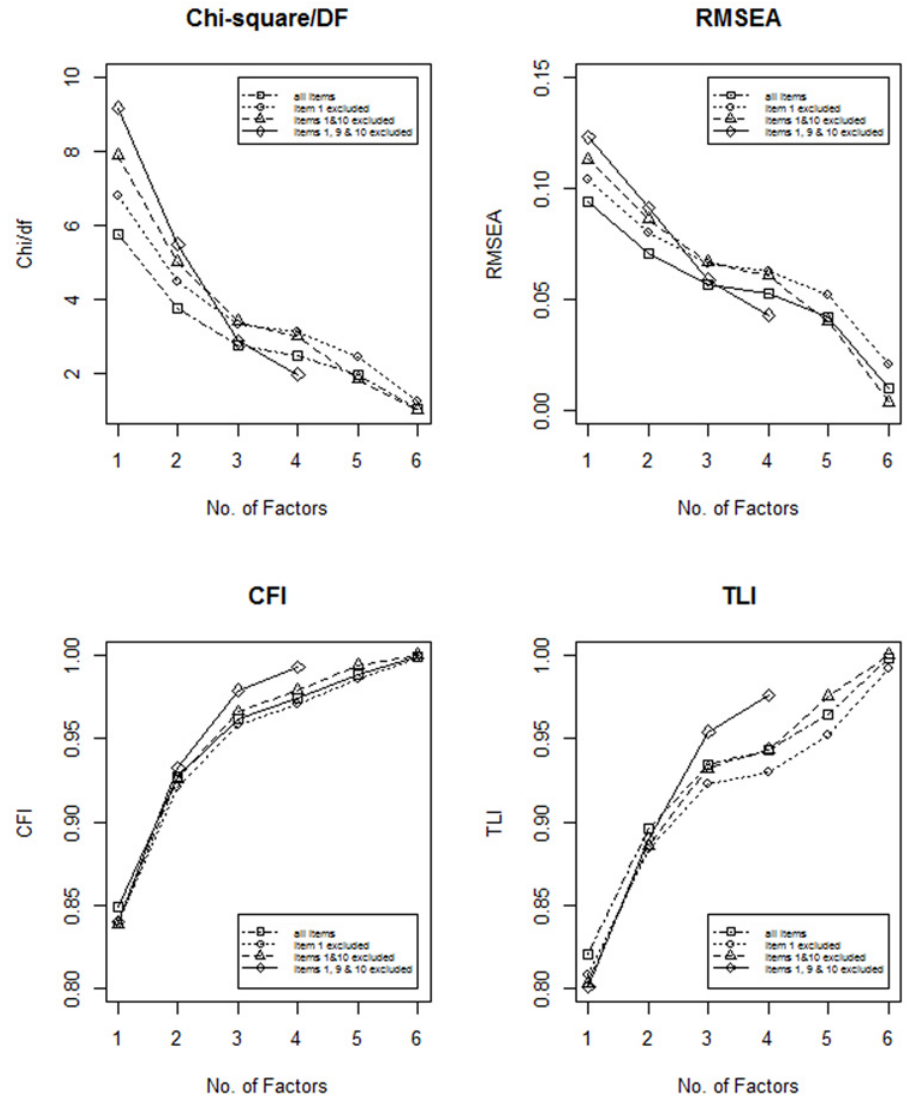
Fig 1. The fit indices of the ESEM models of ER. The X-axis is always the number of factors, while the Y- axis is a fit index. Upper left corner: Chi-square / degrees of freedom. Upper right corner: Root mean square error of approximation. Lower left corner: Comparative Fit Index. Lower right corner: Tucker-Lewis Index. Different types of lines mark the number of items included in the analysis (first item 1 was excluded, then item 10, then item 9). Factors did not converge after the exclusion of the three ill-fitting items above four solutions. The ‘ elbow ’ is visible at three factors in all